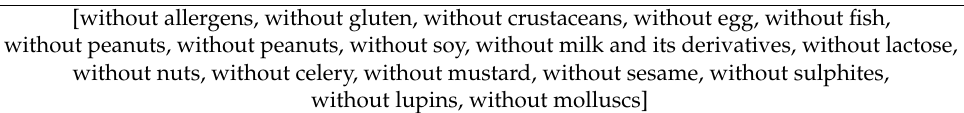
Table 10. String values obtained from the Messages columns. [without colorings, without preservatives, without additives, without transgenics, without gluten, without artificial colors, without trans fats, without artificial flavors, without fat, without molluscs, without lactose, without artificial preservatives, without sugar, without egg, without milk and its derivatives, without cholesterol, without added preservatives, without added sugar, without salt, without palm oil, without soy, without added salt, without nuts, without peanuts, without palm , without sesame, without peanuts, without sulfites , without mustard, without saturated fat, without alcohol, without calories, without caffeine, without sweeteners, without hydrogenated fats, without palm oil and fat, high protein, without added phosphates, without allergen, starch free, celery free, without artificial sweeteners, without fish, without crustaceans, without glutamate, without lupins, low fat, low in energy] Table 11. Allergen features in the withoutwords vector. [without allergens, without gluten, without crustaceans, without egg, without fish, without peanuts, without peanuts, without soy, without milk and its derivatives, without lactose, without nuts, without celery, without mustard, without sesame, without sulphites, without lupins, without molluscs]